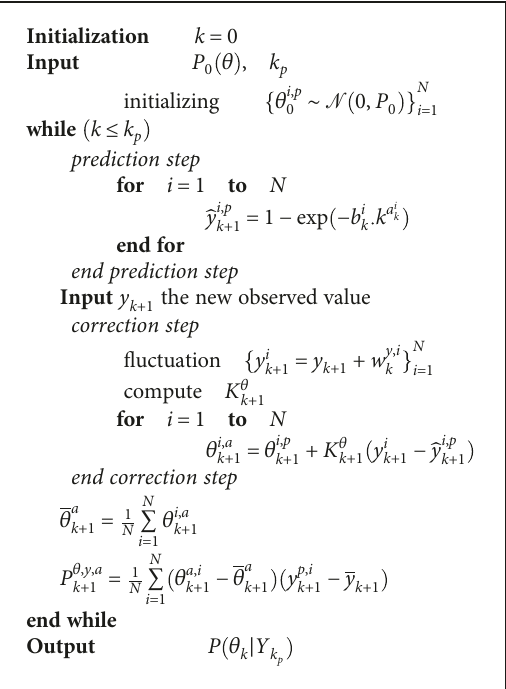
Figure 1: The Bayesian fi ltering steps for k ∈ ⟦ 1, k